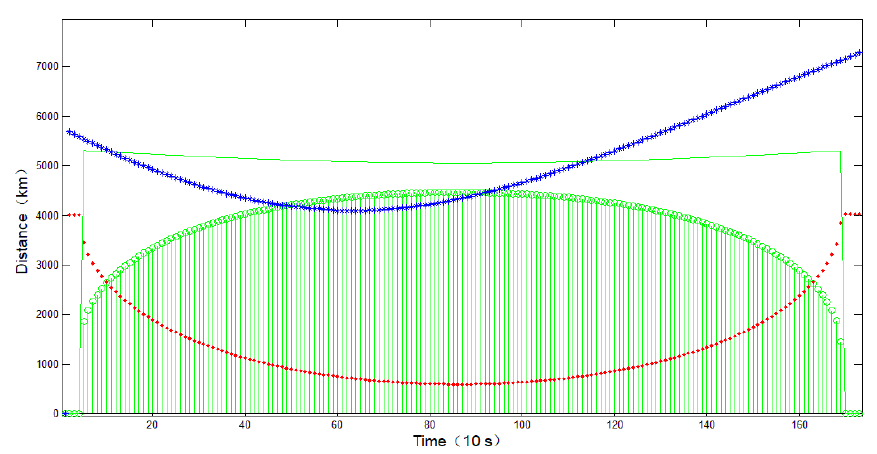
Figure 11. Time sequence of detection area variation.